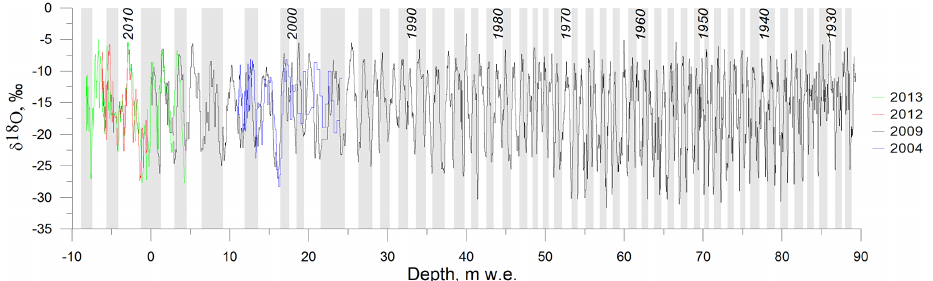
Figure 7. δ 18 O profiles of the cores obtained in 2004, 2009, 2012, 2013. 0m depth corresponds to the 2009 surface. Grey and white boxes depict annual